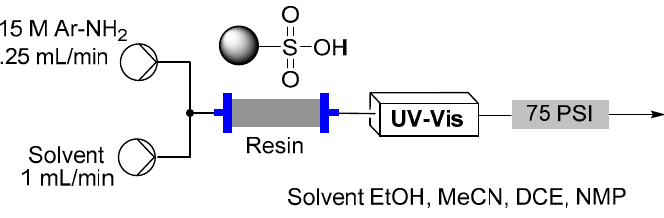
Figure 7. Flow reactor for diazonium formation under heterogeneous conditions.